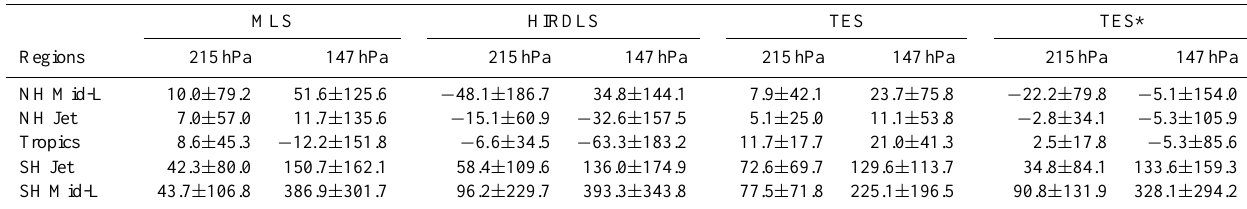
Table 2. Mean biases and RMS errors (unit: ppb) of CTM versus MLS, HIRDLS, and TES for five regions at 215hPa and 147hPa for July 2005 a .